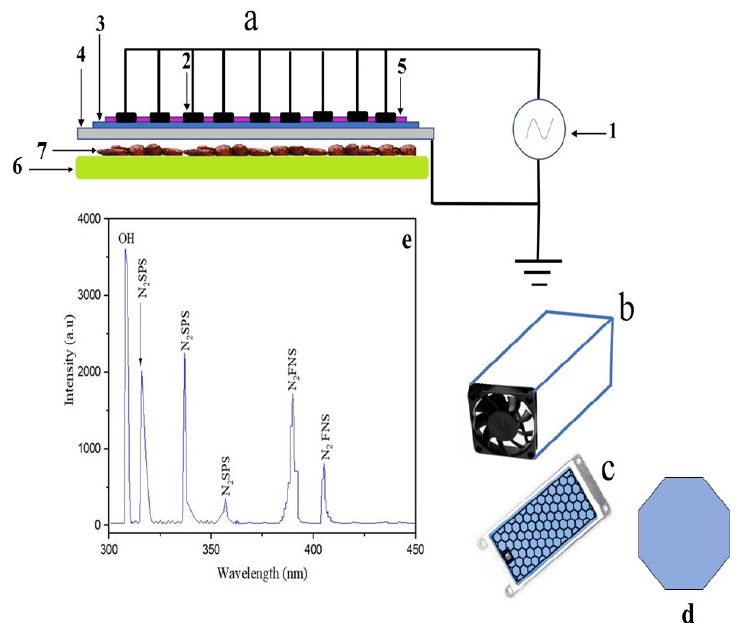
Figure 1. SDBD electric circuit ( a ); (Power supply (1), HV electrode (2), Dielectric barrier (3), Ground electrode (4), Plasma (5), Sample holder (6) Palm date samples (7)), Teflon box contains the SDBD system ( b ), honeycomb geometry of SDBD ( c ), the cell geometry of honeycomb ( d ), and the emission spectrum of the plasma from SDBD in the range of (200–900 nm) ( e ).